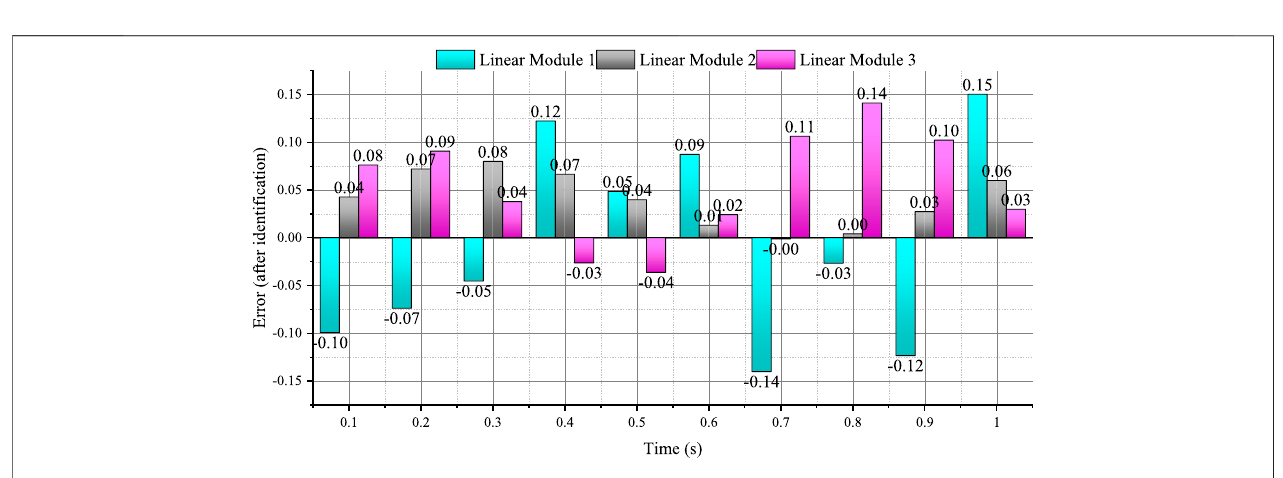
FIGURE 6 | The error between the calculated value and the measured value of the driving torque of the linear module (after identi fi cation).